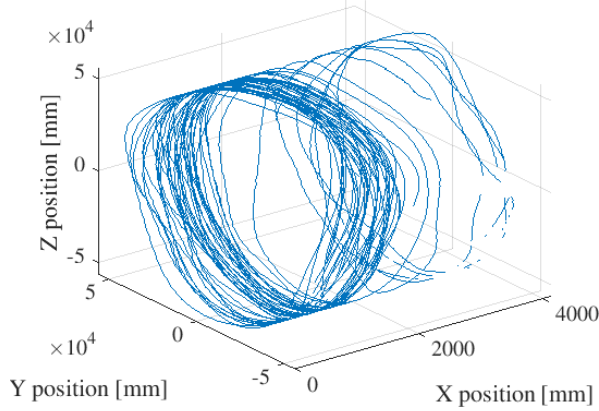
Figure 10. Track of one measurement point of DIC without align- ment.